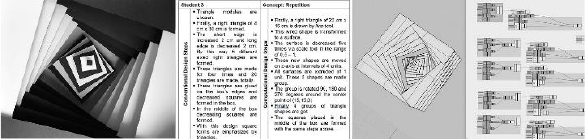
Figure 9. An example of the second method: the physical model, the design steps and the 3D